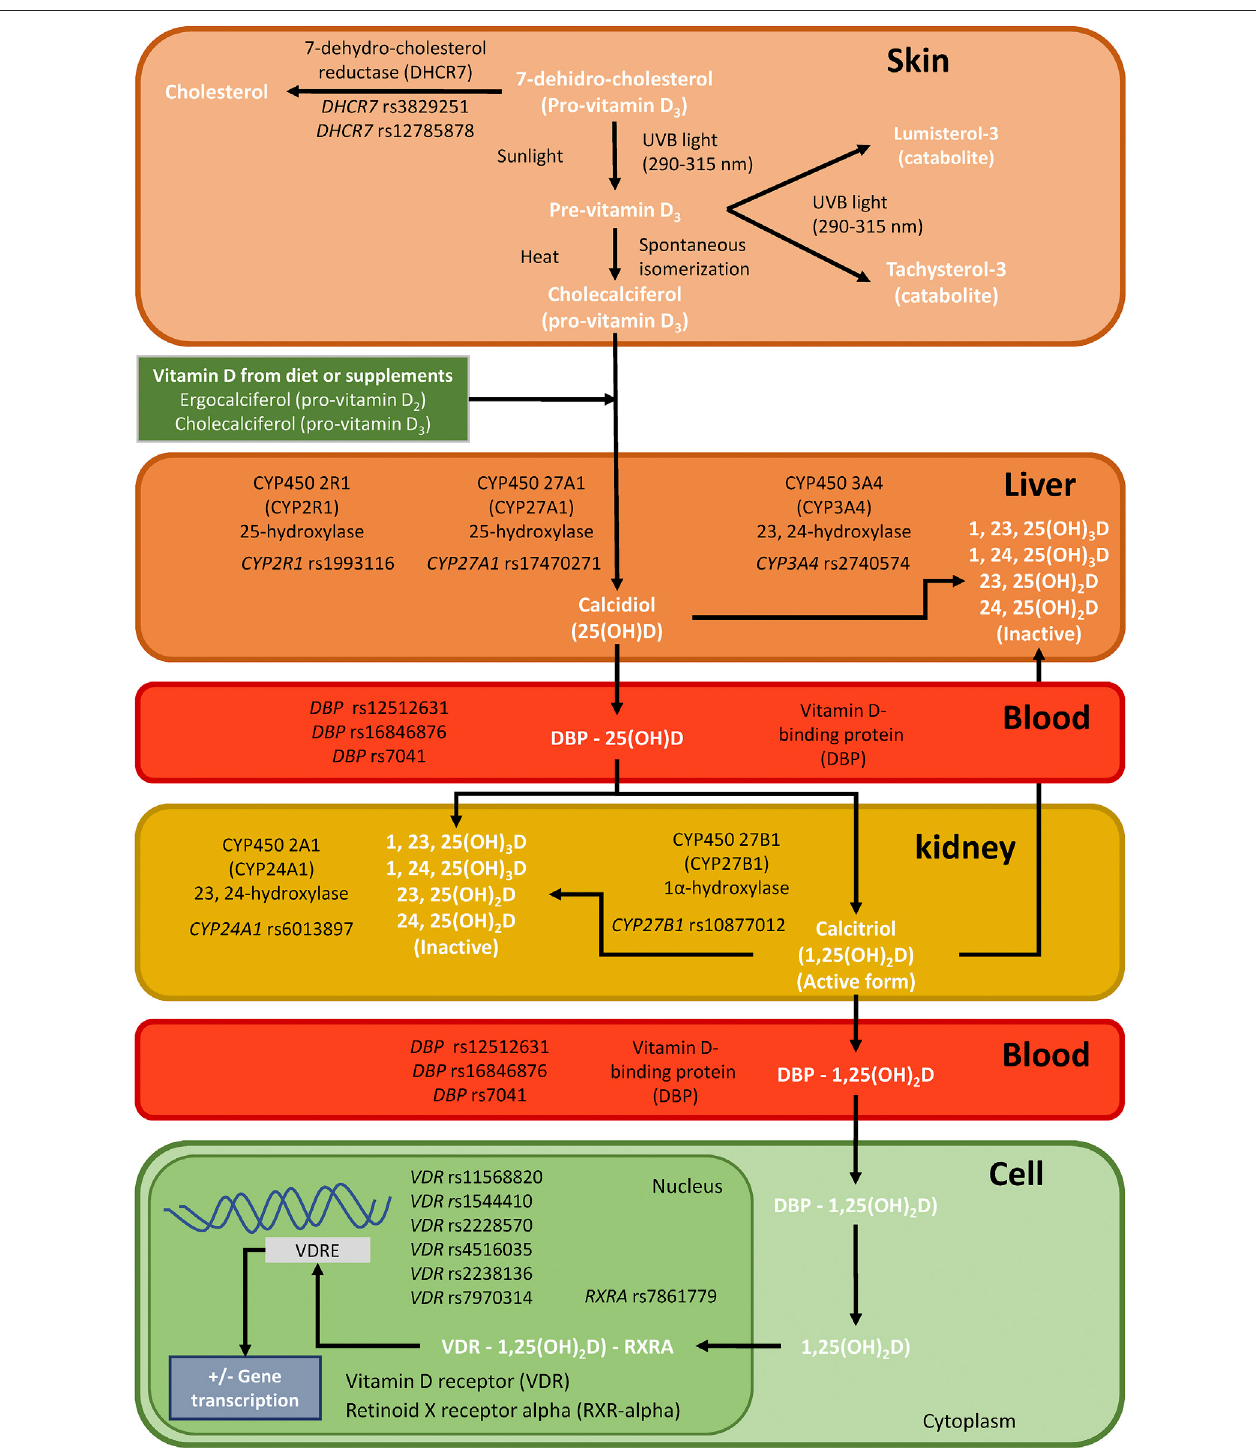
FIGURE 1 | Summary of single nucleotide polymorphisms (SNPs) analyzed for this study in genes related to the synthesis, transport, and mechanism of action of vitamin D in the body.; Abbreviations: DHCR7, 7-dehydrocholesterol reductase; CYP2R1, cytochrome P450 enzymes; CYP27A1, cytochrome P450 enzymes; CYP27B1, cytochrome P450 enzymes; CYP3A4, cytochrome P450 enzymes; CYP24A1, cytochrome P450 enzymes DBP, vitamin D-binding protein; VDR, vitamin D receptor; and RXRA, retinoid X receptor alpha.